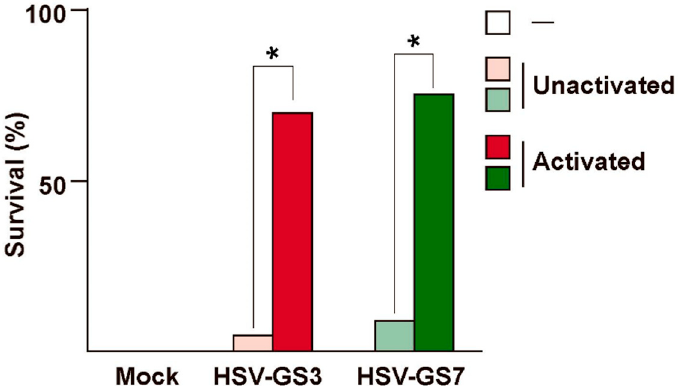
Figure 2. Protective immunity induced by RCCVs HSV-GS3 and HSV-GS7. Mice were inoculated on both rear feet with 50,000 PFU / mouse of either HSV-GS3 or HSV-GS7, or were mock-immunized with saline. For each recombinant, one group of animals was subjected to heat treatment in the presence of ulipristal (activated) and another group did not receive this treatment (unactivated). At 21 days post-inoculation, all mice were challenged with a 20-fold lethal dose of wild-type HSV-1 strain 17 syn + applied to both rear feet. The data are presented as percent survival (at 26 days post challenge) for each treatment group ( n = 20 for each HSV-GS3 or HSV-GS7 group; n = 10 for the mock-immunized group; *, p ≤ 0.05). This figure is based on data reported in Reference